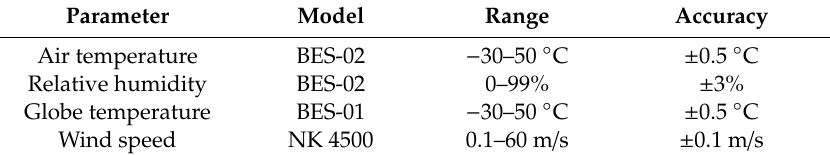
Table 1. Instruments used for measurement of meteorological parameters.